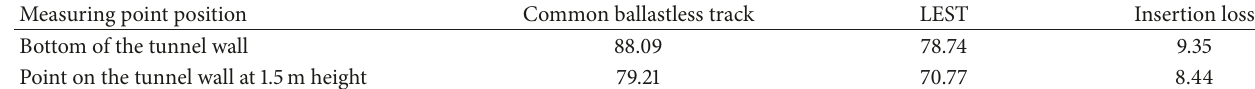
Table 4: Overall vibration levels of the tunnel wall in curved track (1–200 Hz) (dB).